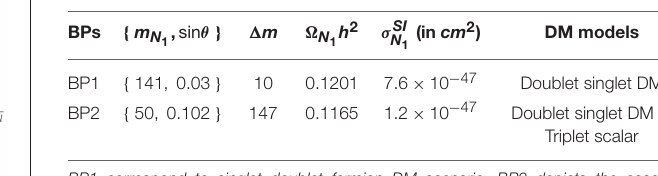
BP1 correspond to singlet doublet fermion DM scenario. BP2 depicts the case of singlet doublet DM model with an additional triplet in the picture. Note here that